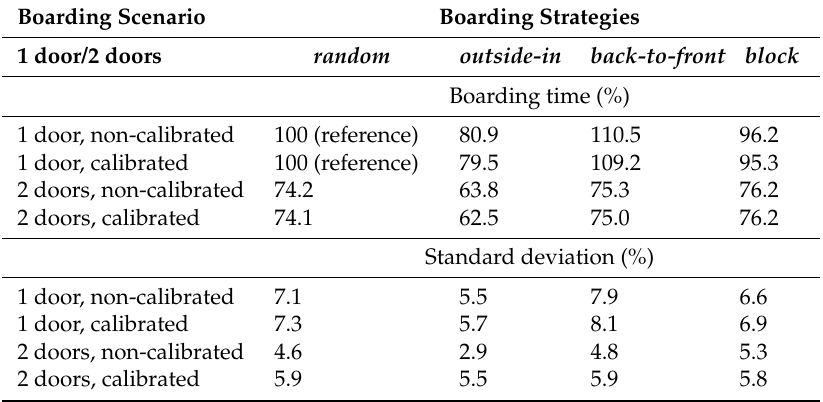
Table 2. Comparison of simulated aircraft boarding strategies using real data for calibration.